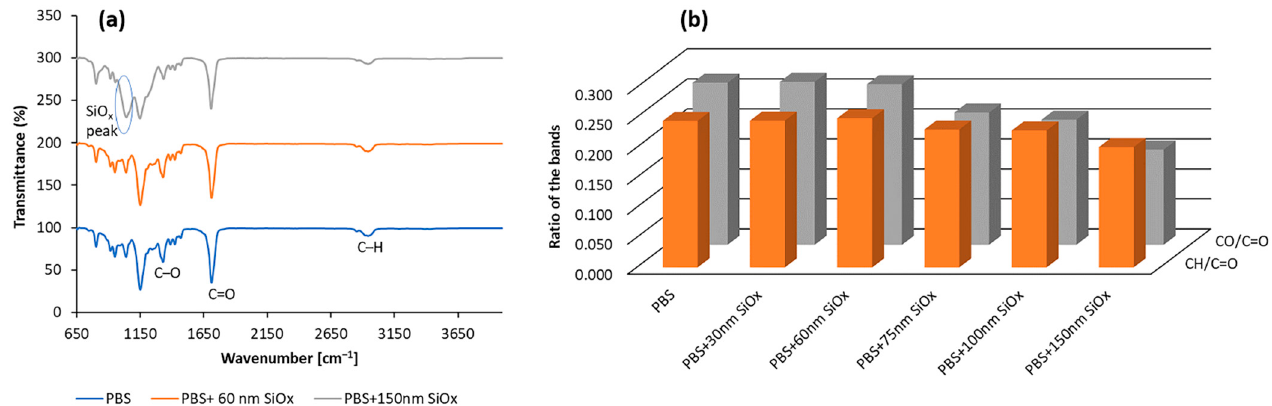
Figure 6. ( a ) FTIR spectra of untreated and SiO x -coated PBS and ( b ) I 2945 /I 1710 and I 1150 /I 1710 intensity ratios evaluated as an integrated area for untreated and SiO x -coated PBS.